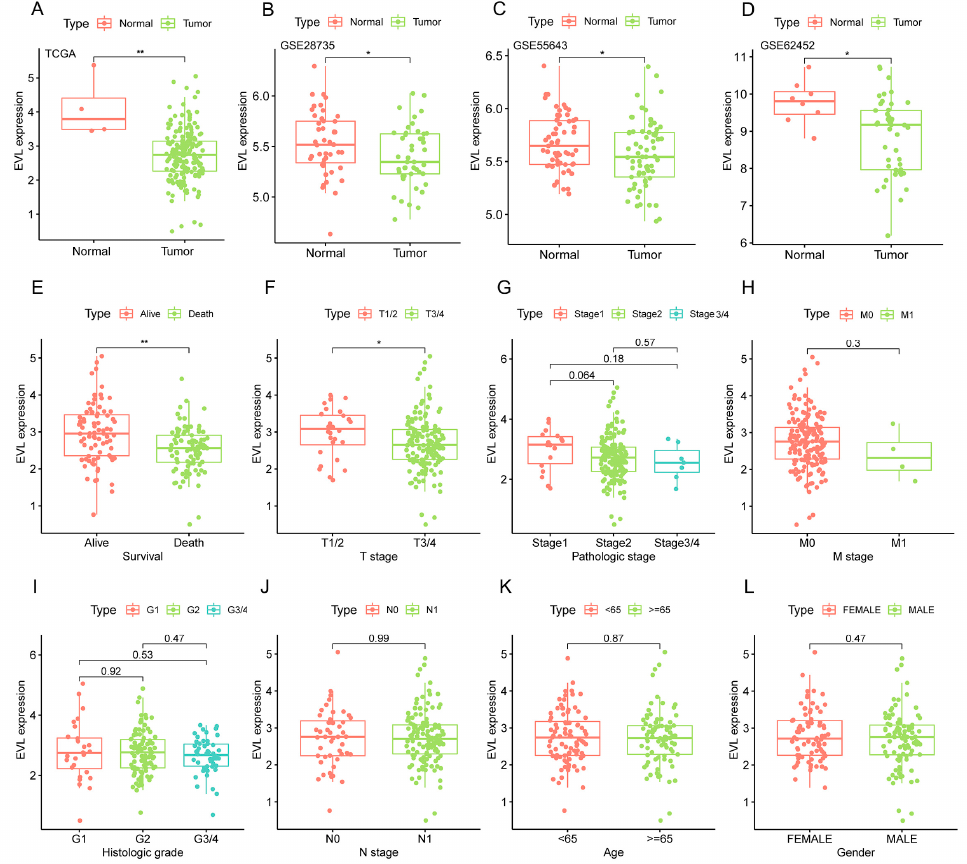
Figure 1. Comparison of EVL expression between different groups in pancreatic cancer. EVL, Ena-VASP-like. * p < 0.05, ** p < 0.01, *** p < 0.001.